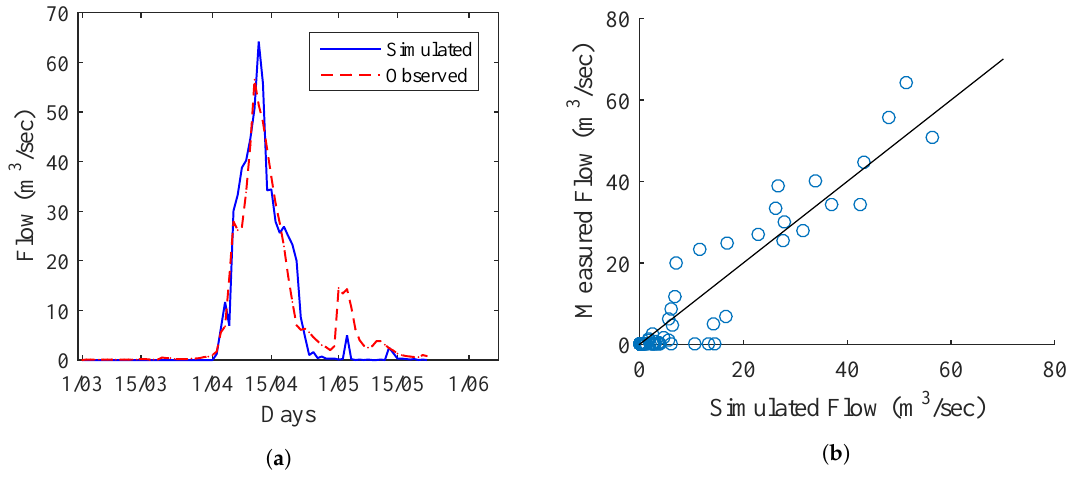
Figure 8. Continuous modelling of daily flow series for the Sturgeon Creek Watershed. The validation is performed for 2011 starting from 1 March 2011–1 June 2011. ( a ) Comparison of observed and simulated hydrograph; ( b ) distributions of points are shown from the y = x line.